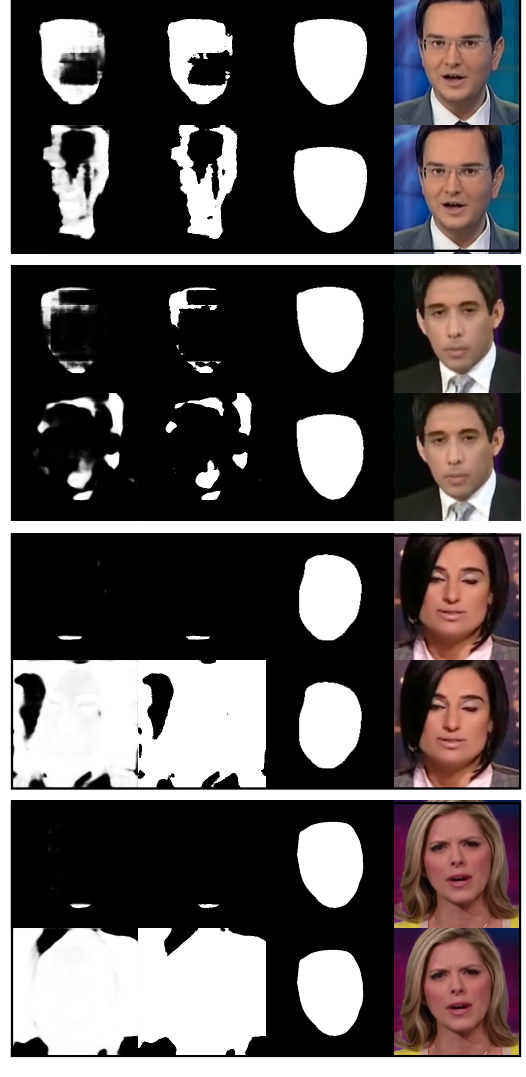
Figure 7. Four rows of randomly selected images from NeuralTextures and their predicted results for the fake region with one-shot fine-tuning. The top sub-row of each row is the result generated by the proposed method, and the bottom sub-row of each row is the result without using the proposed method. In each sub-row, from right to left, there is the image altered by Face2Face , the ground truth of the altered region (mask), the binary predicted output, and the gray-scale predicted